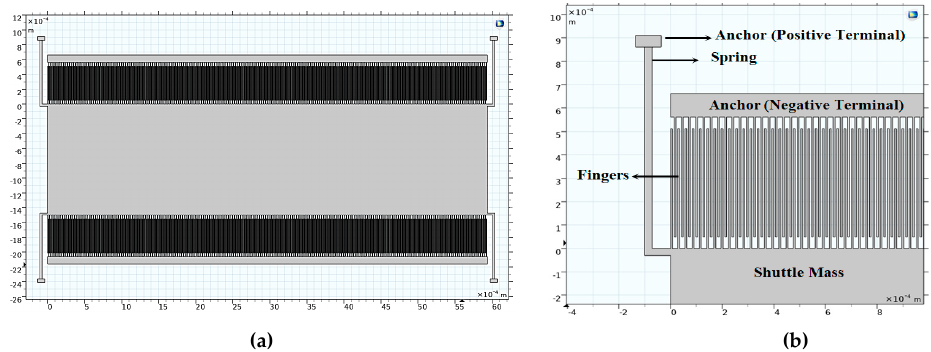
Figure 2. ( a ) The 2D converter structure and ( b ) a focus of the structure showing a clear view.